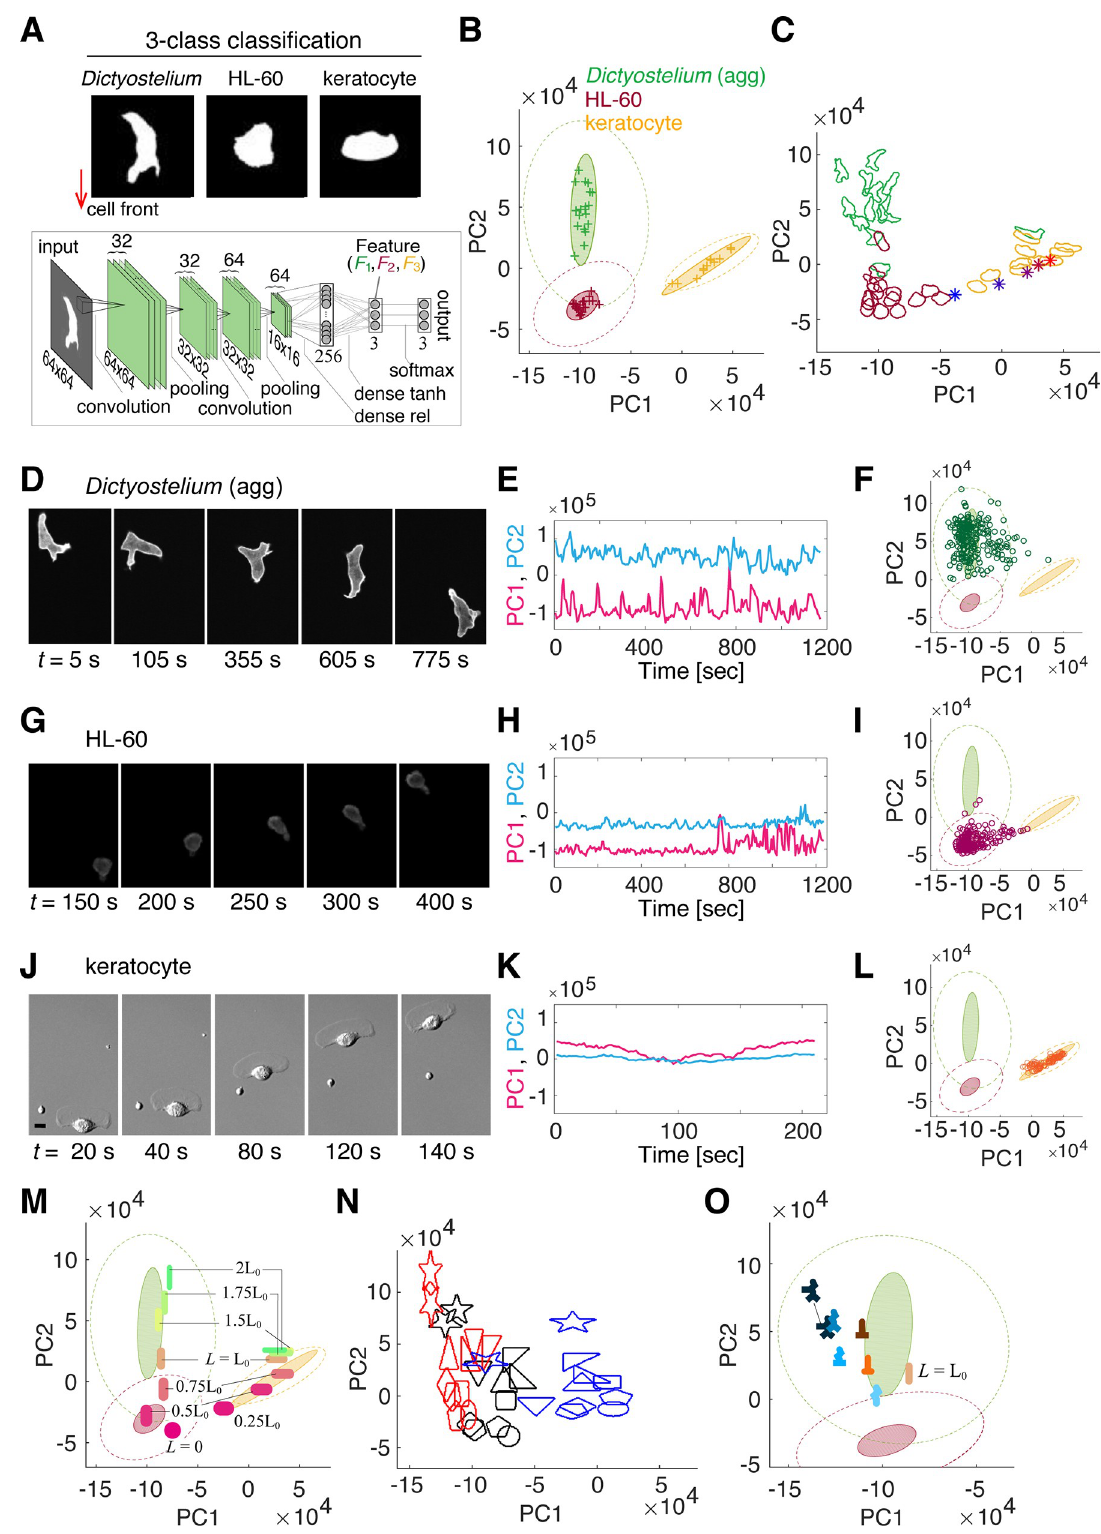
Fig 1. Stereotype migrating cell morphology can be classified in two-dimensional feature space. (A) Representative mask images (upper panels: Dictyoselium (agg; aggregation-stage), HL-60 and fish keratocyte) used for trainining a deep convolutional neural